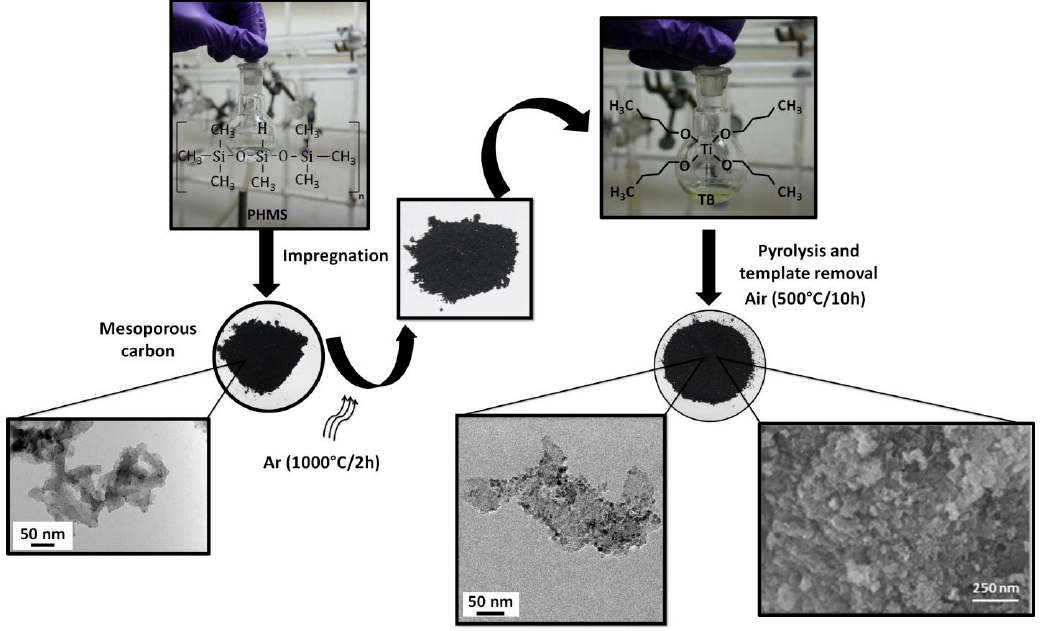
Figure 2. Schematic diagram illustrating the generalized process for the synthesis of mesoporous TiO 2 /SiOC